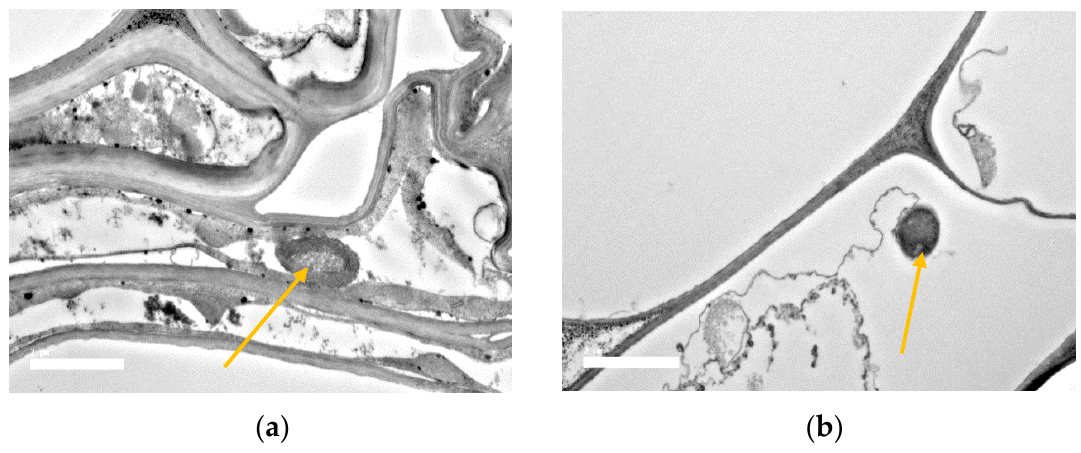
Scheme 3. TEM micrograph showing the colonization of UPMRB9 on roots of BRRI dhan67. The yellow arrow shows UPMRB9 ( a ) in intercellular spaces and ( b ) within the epidermis under saline conditions.